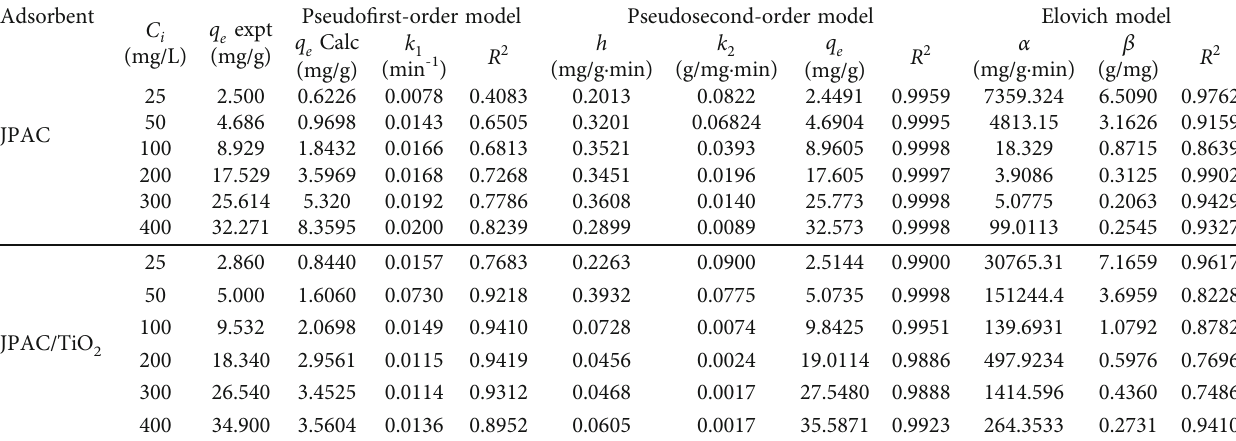
Table 4: Kinetic constants of Red 2BN on JPAC and JPAC/TiO